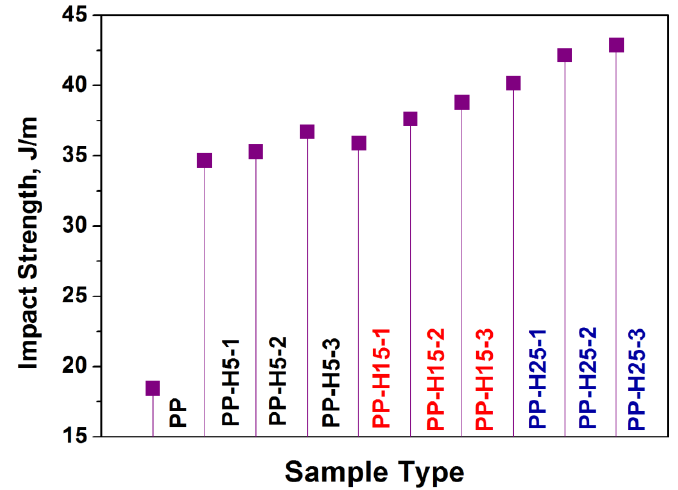
Figure 6. Dependence of nanocomposites on impact strength for different types of GNPs.